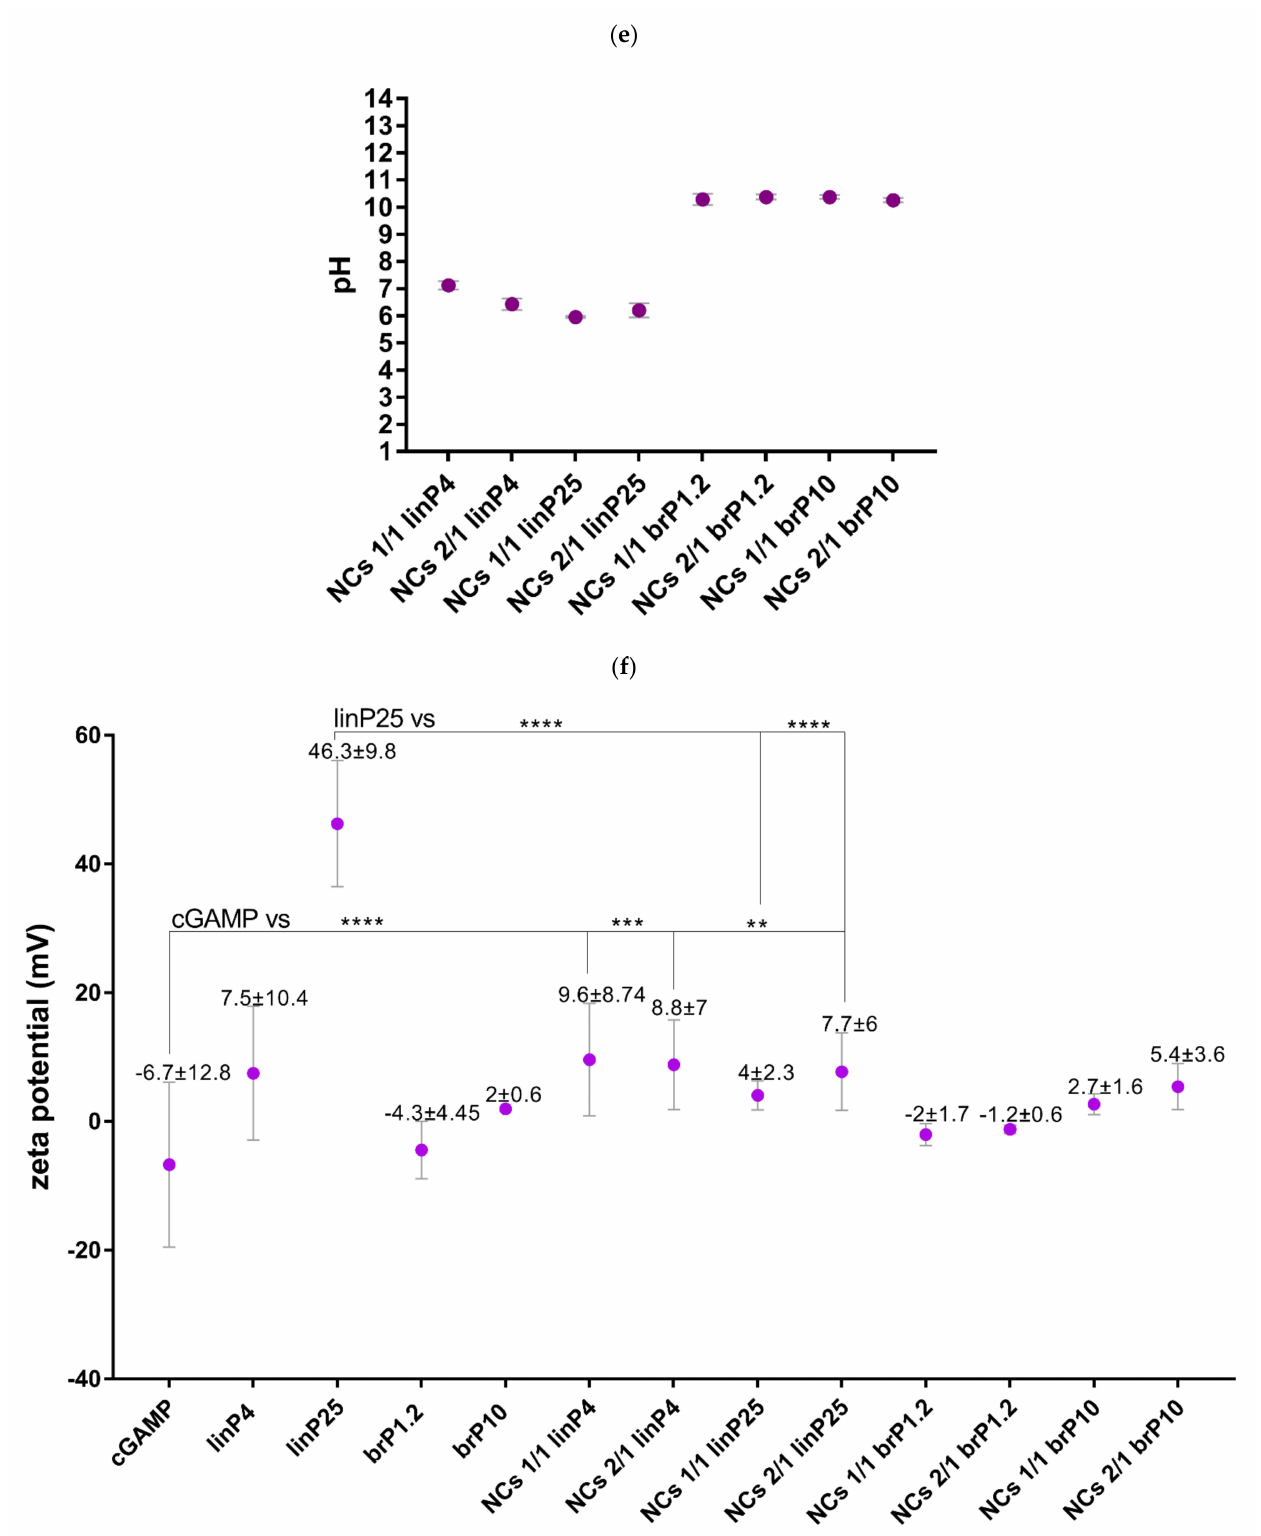
Figure 1. DLS: Media influence on size (z-average) and PDI of PEI/cGAMP NCs (0.01